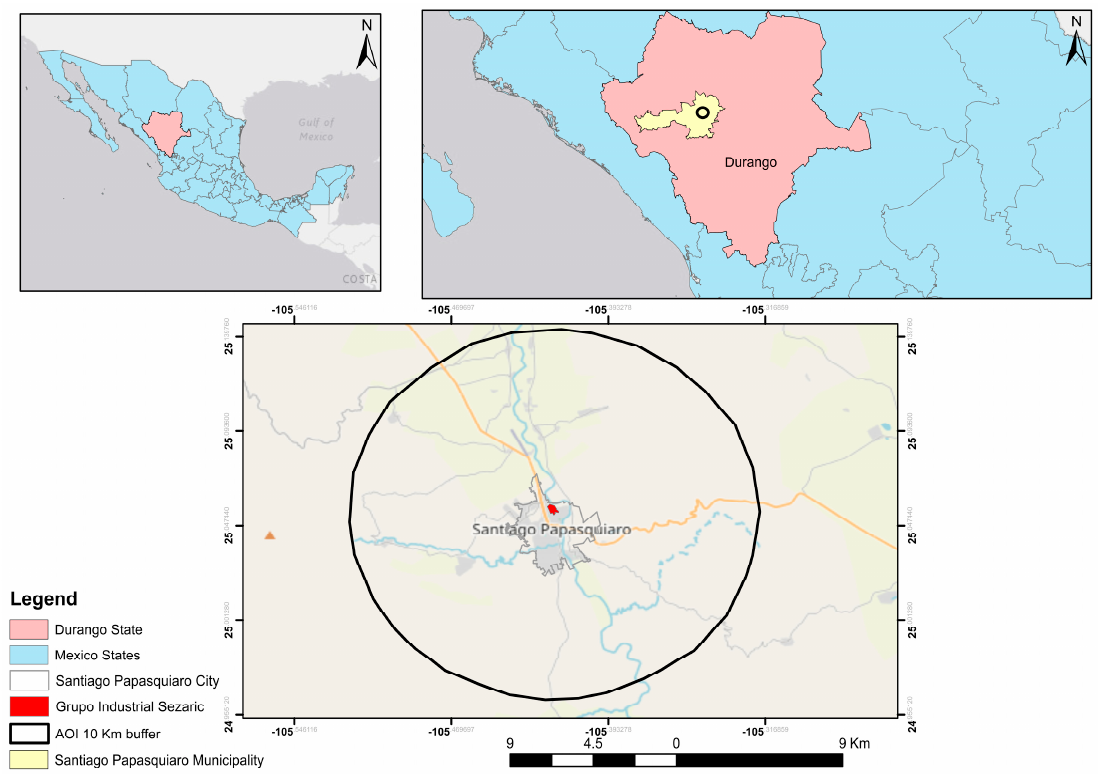
Figure 2. Study area map, part of Santiago Papasquiaro city.